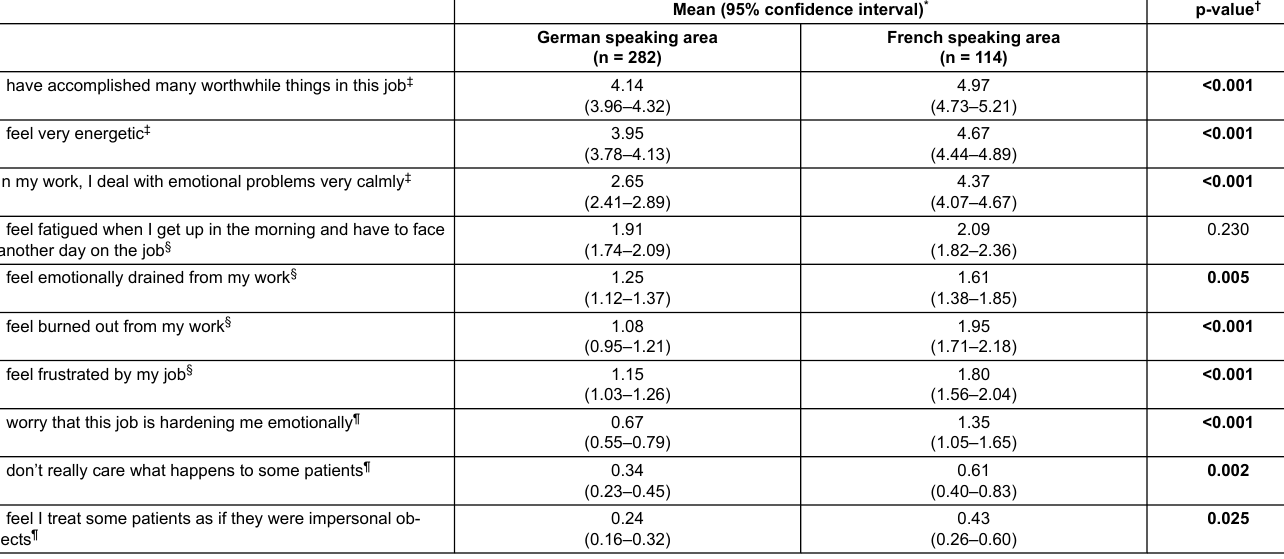
Table 3: Selected questions from the Maslach Burnout Inventory: by